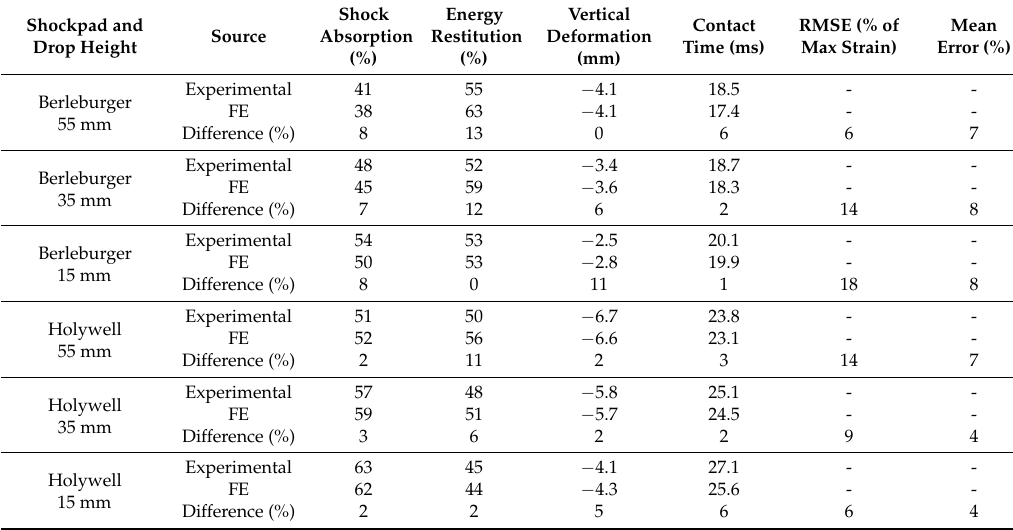
Table 3. Experimental and FE simulation results from first drop of AAA for the Berleburger and Holywell